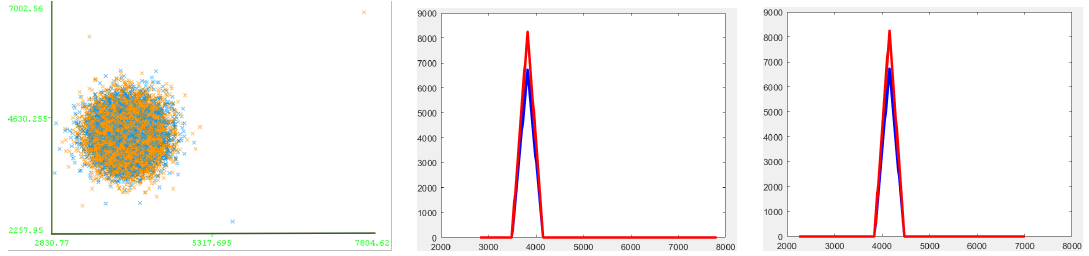
Figure A8. Scatter and Histogram of EEG